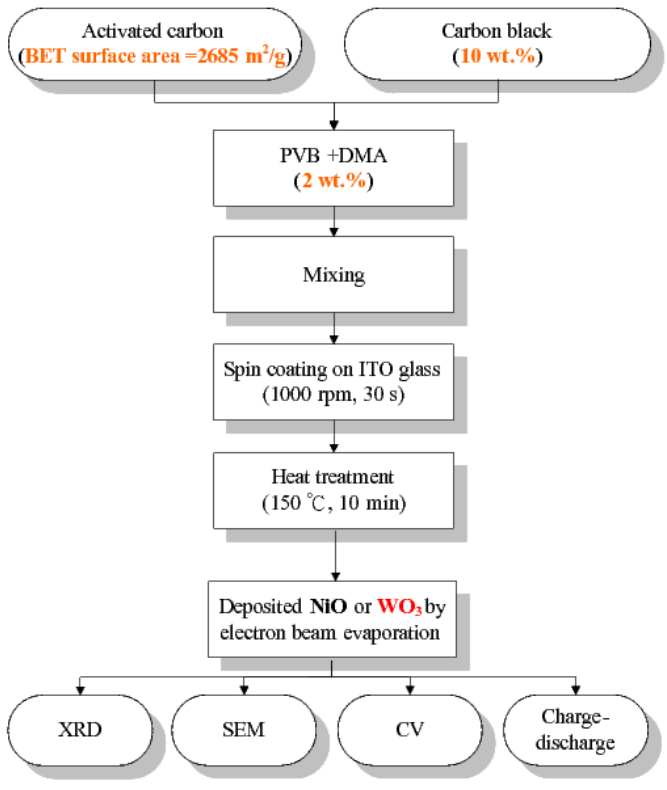
Figure 1. The preparation flow diagram of the composite electrode.